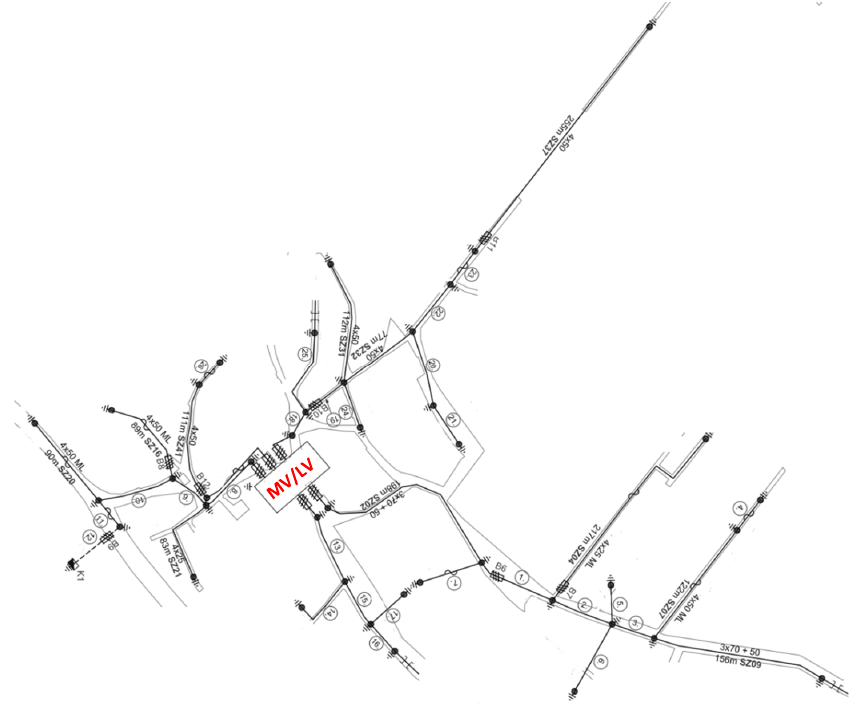
Figure A3. Topology of area 44600 (MV/LV represents the supplying medium/low-voltage trans- former).